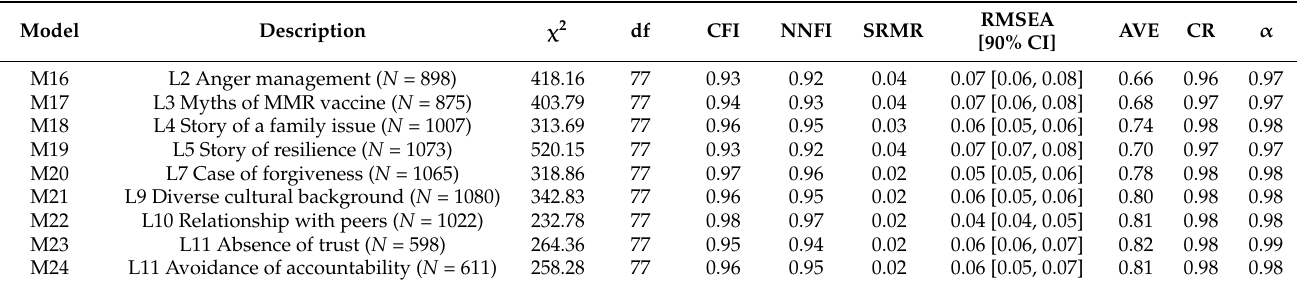
Table 4. CFA findings of the 14-item SOES for the Nine Case-Based